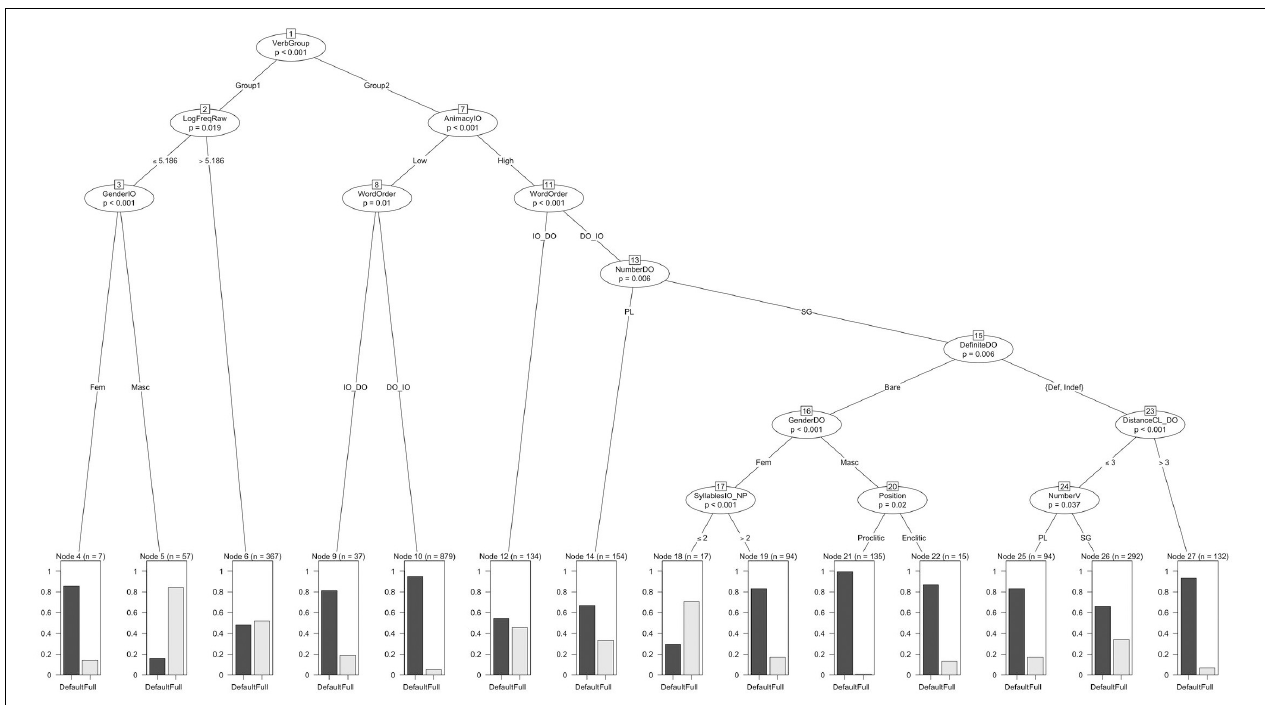
FIGURE 5 | Conditional inference tree with Agreement ( defaults vs. full ) as dependent variable.